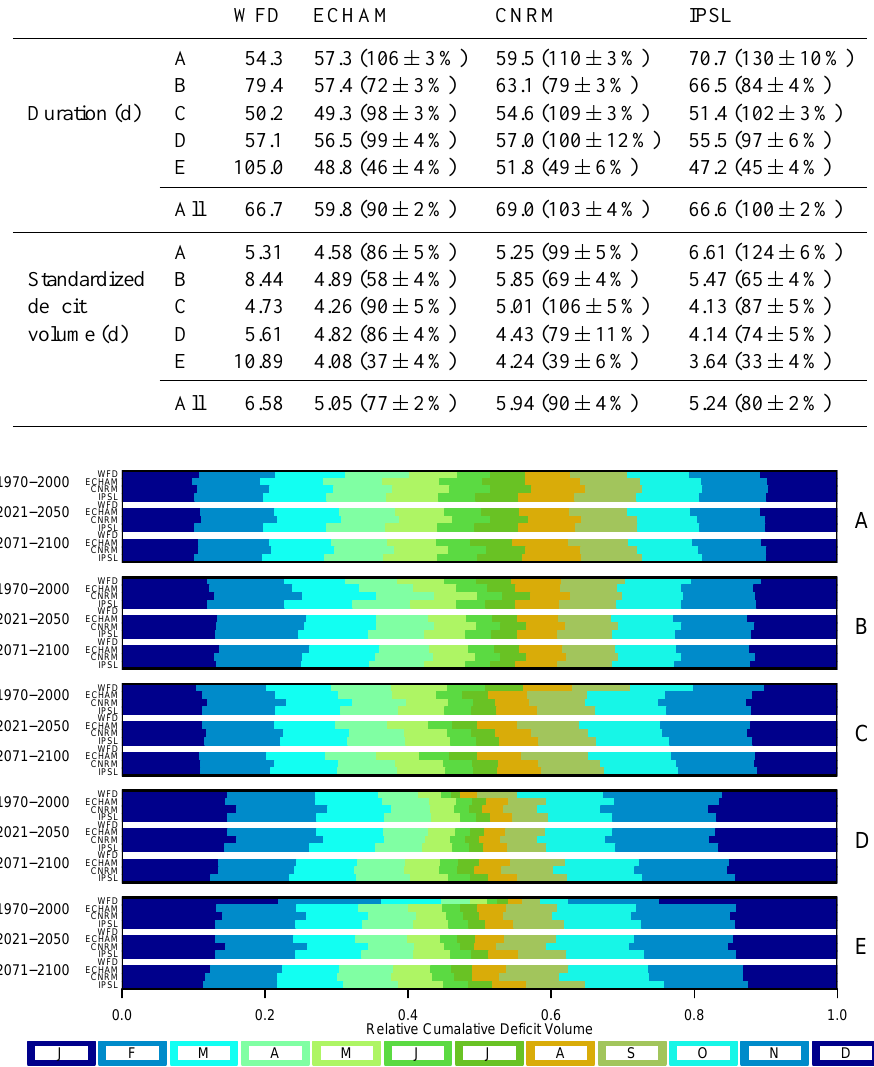
Figure 6. Monthly distribution of the annual total cumulative deficit volume over the year, obtained from simulations of the conceptual hydrological model, using meteorological forcing by the WATCH Forcing Data (WFD) and GCMs: ECHAM, CNRM and IPSL. Results are shown per analysis period and for each major climate type